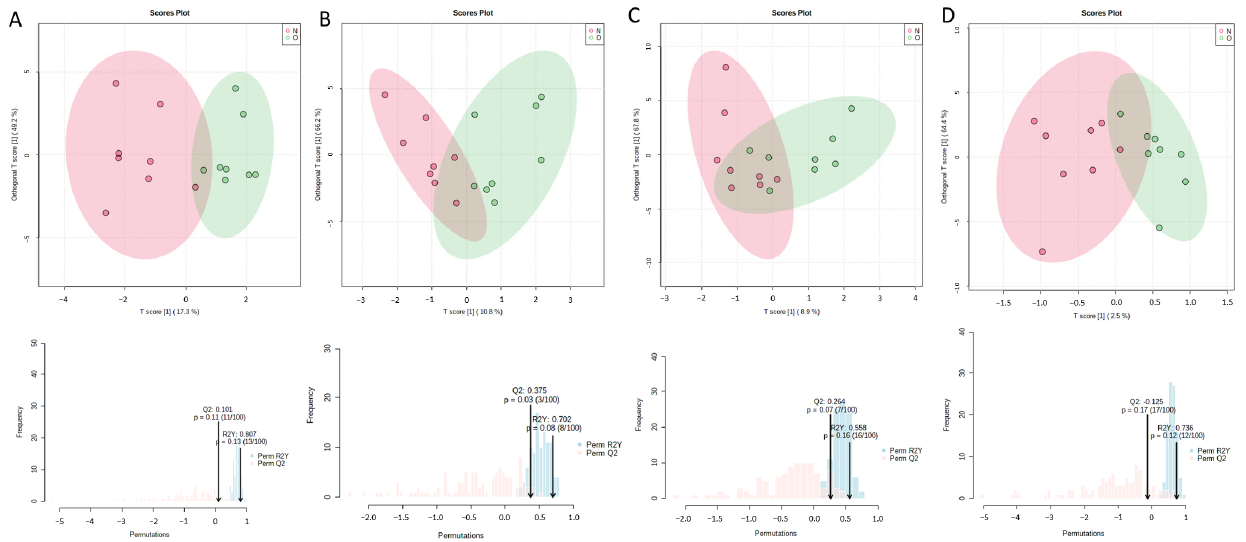
Figure 4. Multivariate statistical analysis of GC-MS data. OPLS-DA score plots and permutation test results of bone marrow fatty acids 5 ( A ), 7 ( B ), 21 ( C ) and 28 ( D ) days after OVX surgery ( n = 8 rats per group). N: Sham group, O: OVX group. Table 1. OPLS-DA and t -test results of fatty acids.